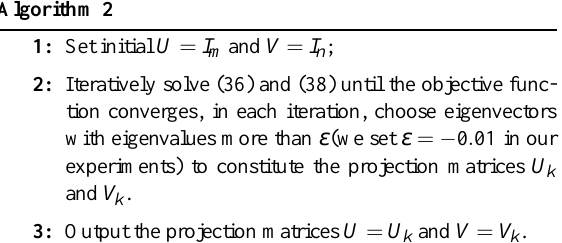
Figure 2: Algorithm 2 with automatical selection suitable feature